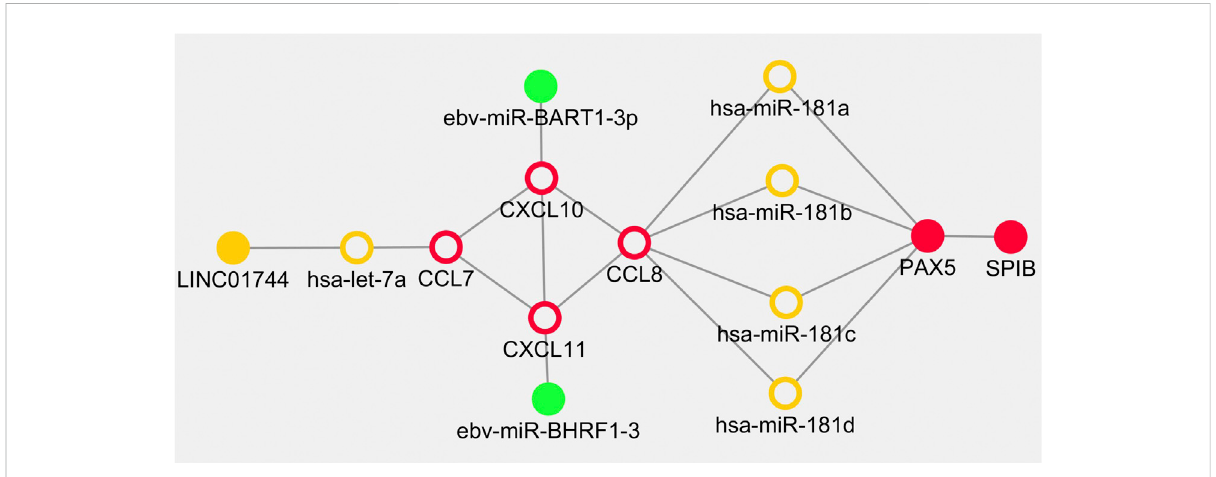
FIGURE 8 Dynamicalnetwork biomarkersfor regulation inEpstein-Barr virus (EBV)positive peripheralTcelllymphoma unspeci fi edtype(PTCL-U).Target genes are labeled in red circles, transcription factors are re fl ected by red dots, miRNAs are indicated by orange circle, lncRNAs are represented in orange dots, and EBV-related miRNAs are illustrated in green